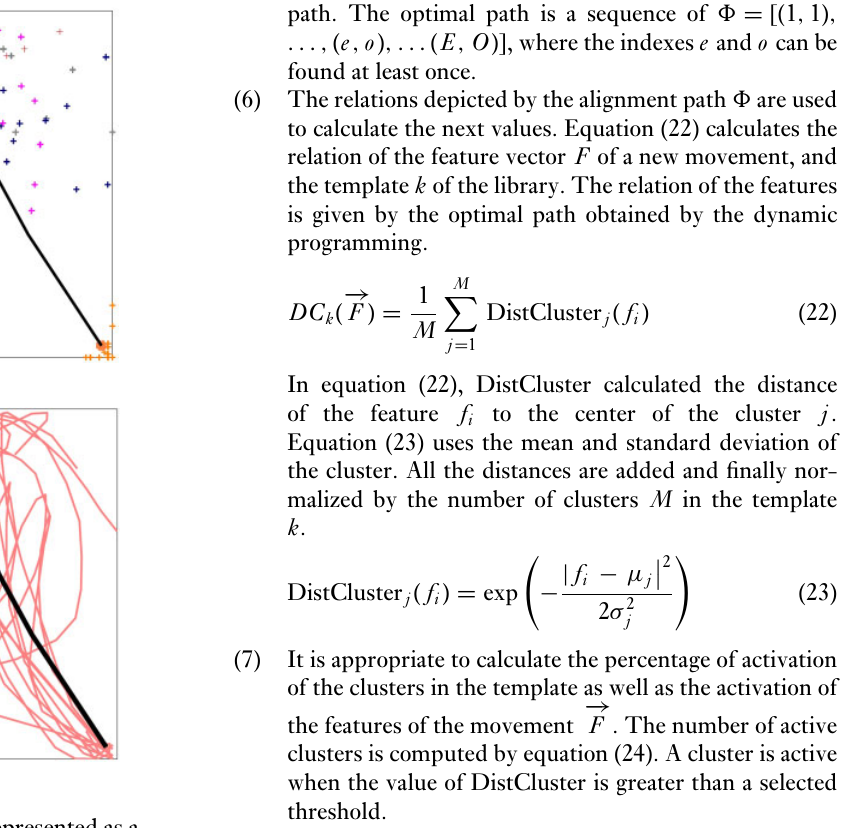
Figure 5 (a) A template in the library is represented as a sequence of clusters. The mean values of each cluster (circular markers) are used as a feature vector. The unique representation for this template is the solid line. (b) Shows the samples that form the template, and the unique